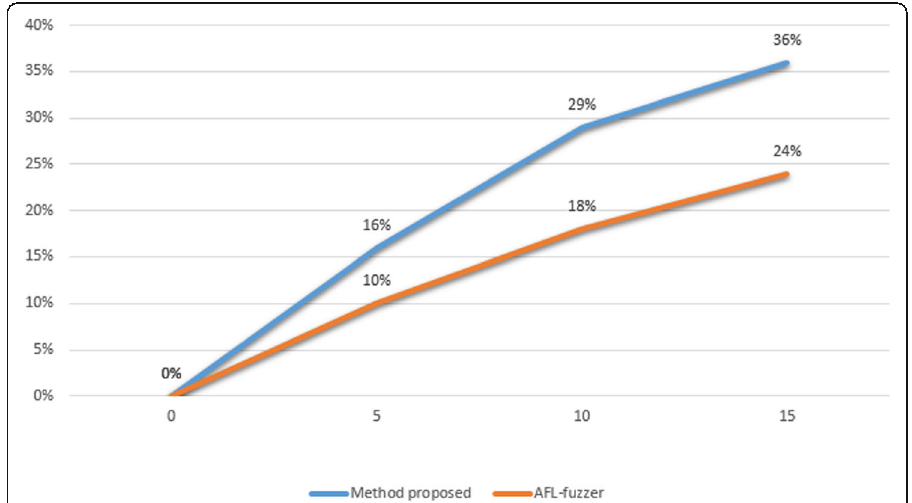
Fig. 11 Code coverage rates with different numbers of